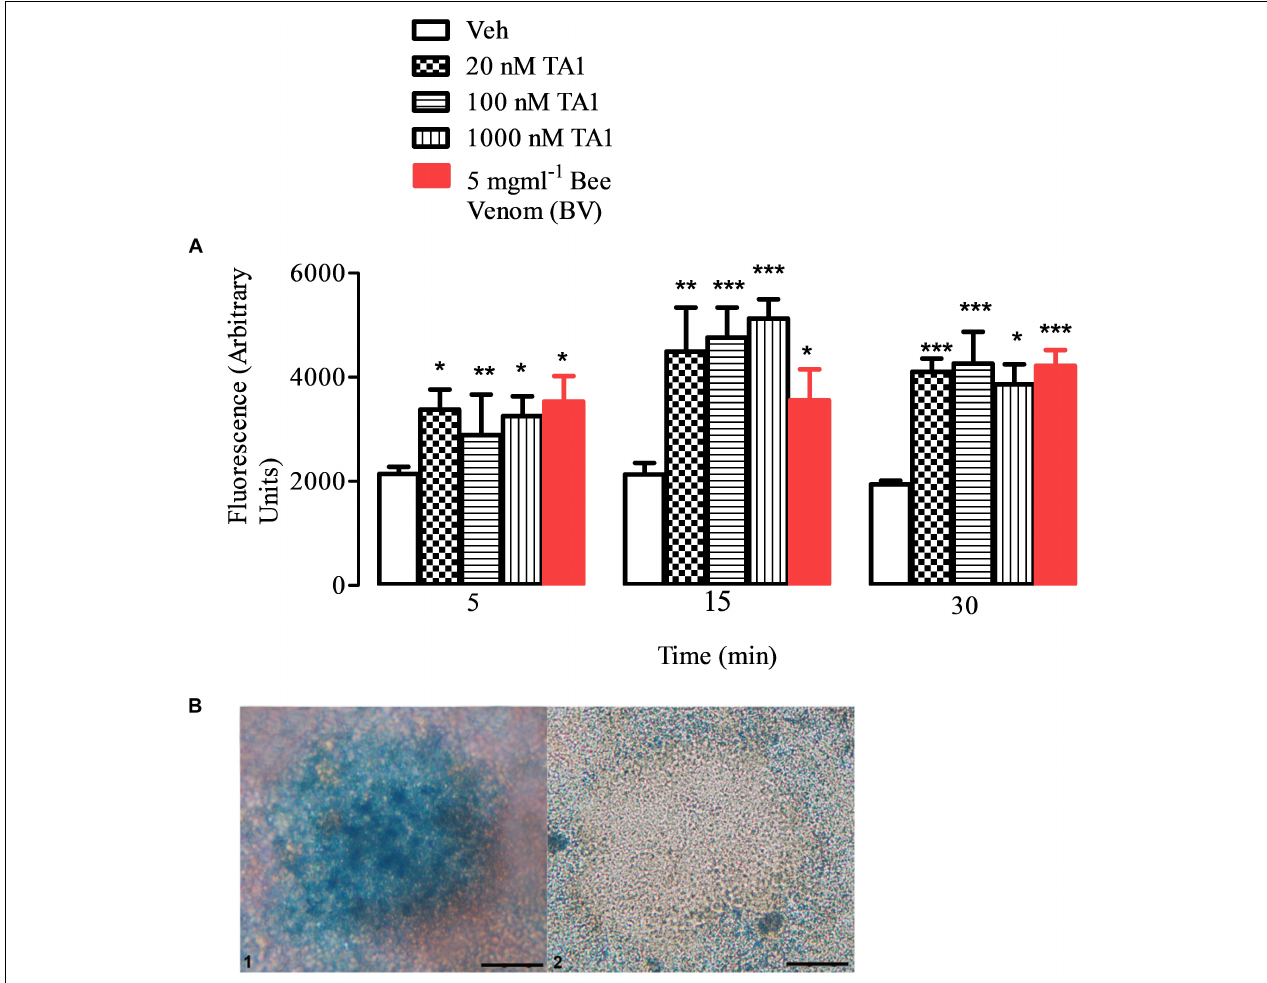
FIGURE 2 | TA1 releases histamine from peritoneal mast cells. Peritoneal mast cells were prepared and exposed to 20, 100, or 1000 nM TA1 as described in Methods. (A) Histamine accumulation was evaluated by fluorescence in cell medium after 5, 15, 30 min of cell exposure to TA1 or to Apis mellifera venom (BV; 5 mgml − 1 ). Results are expressed as means ± SEM of three different experiments run in duplicate ( ∗ P < 0.05, ∗∗ P < 0.01 and ∗∗∗ P < 0.001 vs. Veh.). (B) Picture 1: mast cells stained with Astra Blue following 15 min exposure to Veh. A representative image is showed. Picture 2: representative image of mast cells stained with Astra Blue following 15 min exposure to 1 µ M